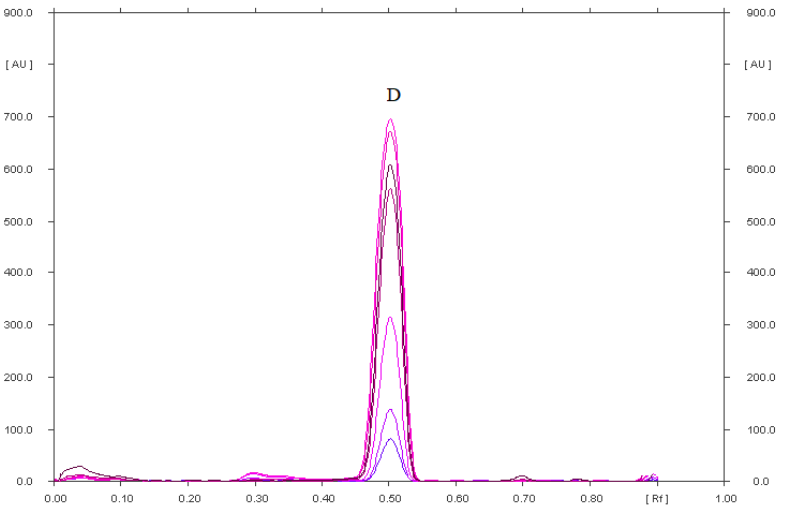
Figure 7. Densitogram of diclofenac sodium (14 µg) after two-dimensional (2-D) separation by TLC using two mobile phases, the first: chloroform–methanol–ammonia (36:4:0.60, v / v / v ) and the second (after drying the chromatogram): cyclohexane–chloroform–methanol–glacial acid acetic acid (6:3:0.5:0.5, v / v / v / v ).